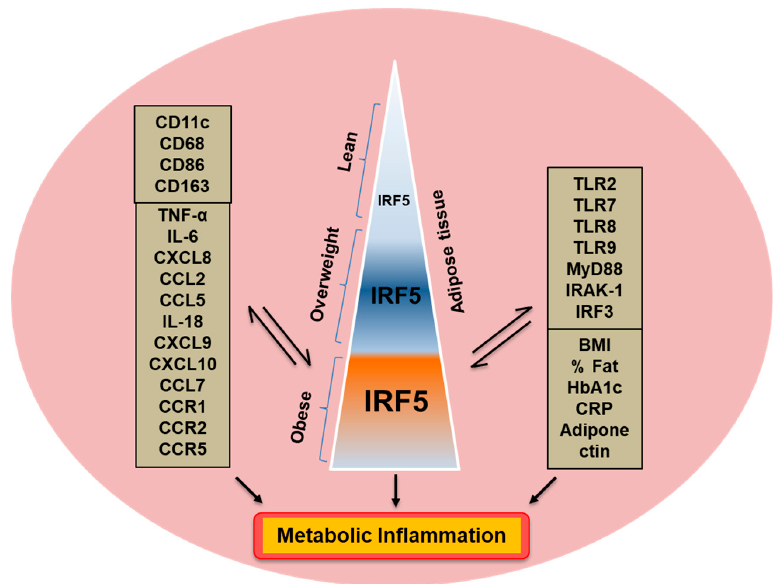
Figure 9. Increased adipose IRF5 expression concurs with metabolic inflammation. The illustration depicts a proposed model of metabolic inflammation, in support of the data presented, wherein the increase in obesity parallels with IRF5 adipose upregulation (positive associations with BMI, body fat percentage, age, and HbA1c). These changes in the IRF5 expression are in agreement with a wide range of markers of adipose inflammation including inflammatory cytokines/chemokines, TLRs and TLR-associated signaling molecules, inflammatory macrophage markers, as well as systemic immune-metabolic markers i.e., a positive association with circulatory CRP and a negative association with adiponectin levels. The two-way arrows ( ) represent a mutual association. Taken together, these changes support the IRF5 upregulation as a novel marker for adipose tissue inflammation in obesity.